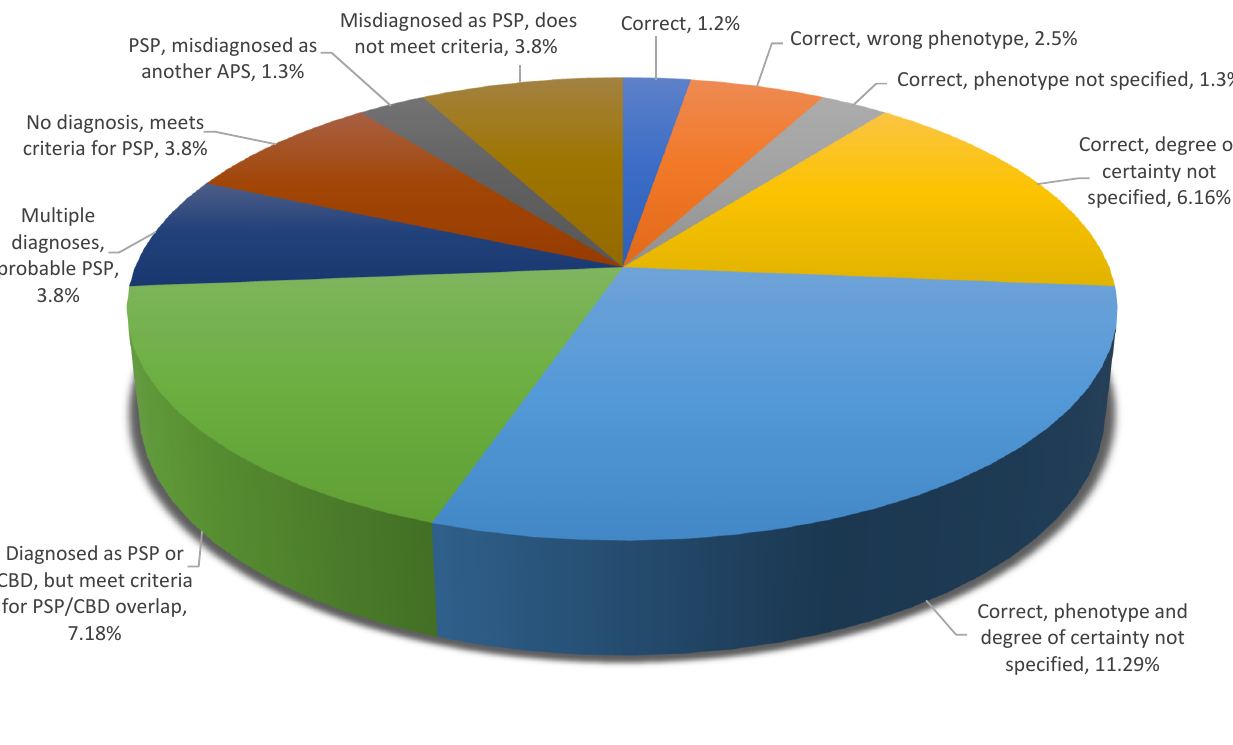
Table 2. Diagnostic accuracy among senior and junior physicians.